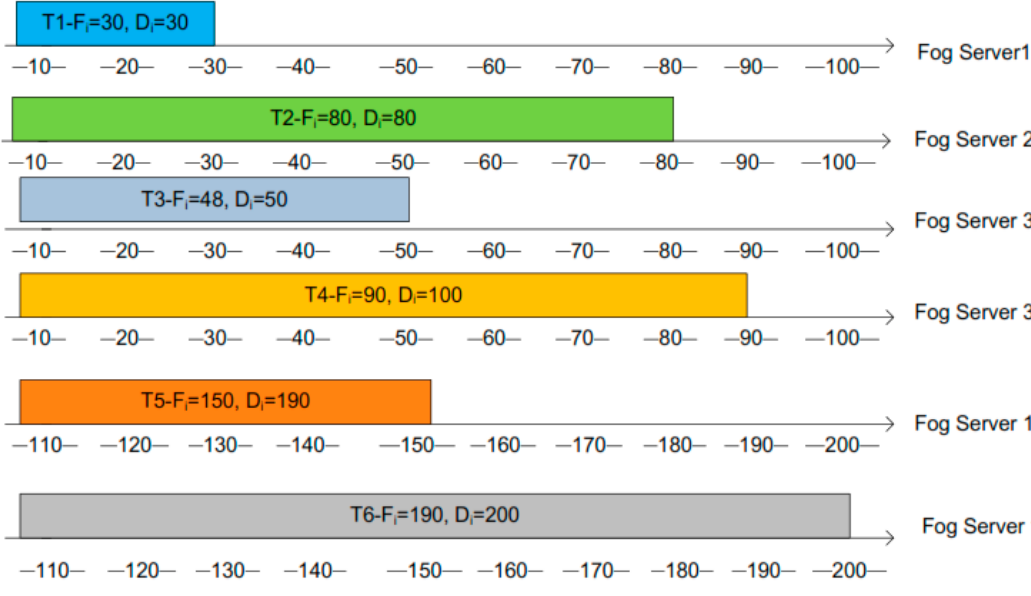
ffi cient fog servers Figure 4. Random and cost-efficient fog servers searching. Figure 4. Random and cost-e